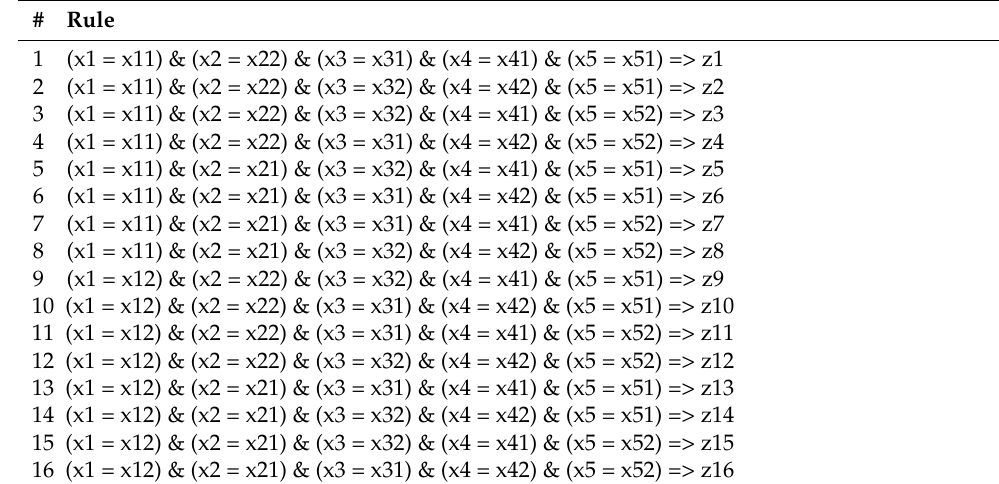
Table 4. Rules of the FIS.